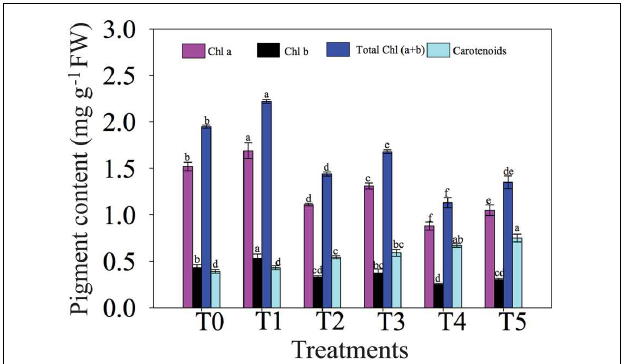
FIGURE 1 | Effects of NO on chlorophyll (Chl) and carotenoid contents in leaves of chickpea plants under salt stress. Data presented are the means ± SEs ( n = 5). Different letters indicate significant difference ( P ≤ 0.05) among the treatments. T0 (control) = 0 mM NaCl + 0 µ M SNAP; T1 = 0 mM NaCl + 50 µ M SNAP; T2 = 50 mM NaCl + 0 µ M SNAP; T3 = 50 mM NaCl + 50 µ M SNAP; T4 = 100 mM NaCl + 0 µ M SNAP; T5 = 100 mM NaCl + 50 µ M SNAP. FW, fresh weight.